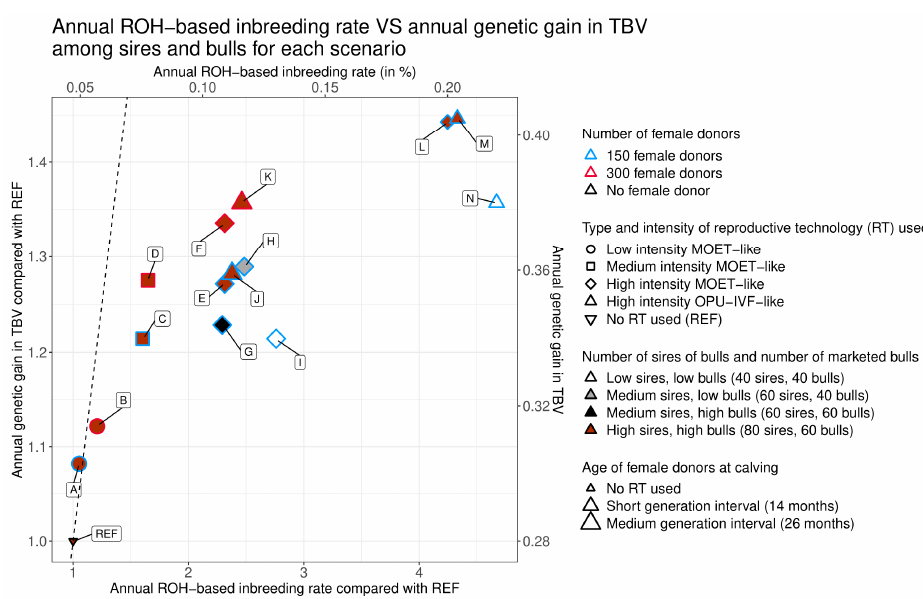
Figure 3. Annual genetic gain versus annual ROH-based inbreeding rate among sires and bulls. Letters indicate the names of the tested scenarios. Comparisons with REF were calculated as the ratio between the estimated value of the parameter for a given scenario and the estimated value of the parameter for the reference scenario (no use of embryo transfer). The dotted line is the line of identity between the annual ROH-based inbreeding rate compared with REF and the estimated annual genetic gain in true breeding value compared with REF.